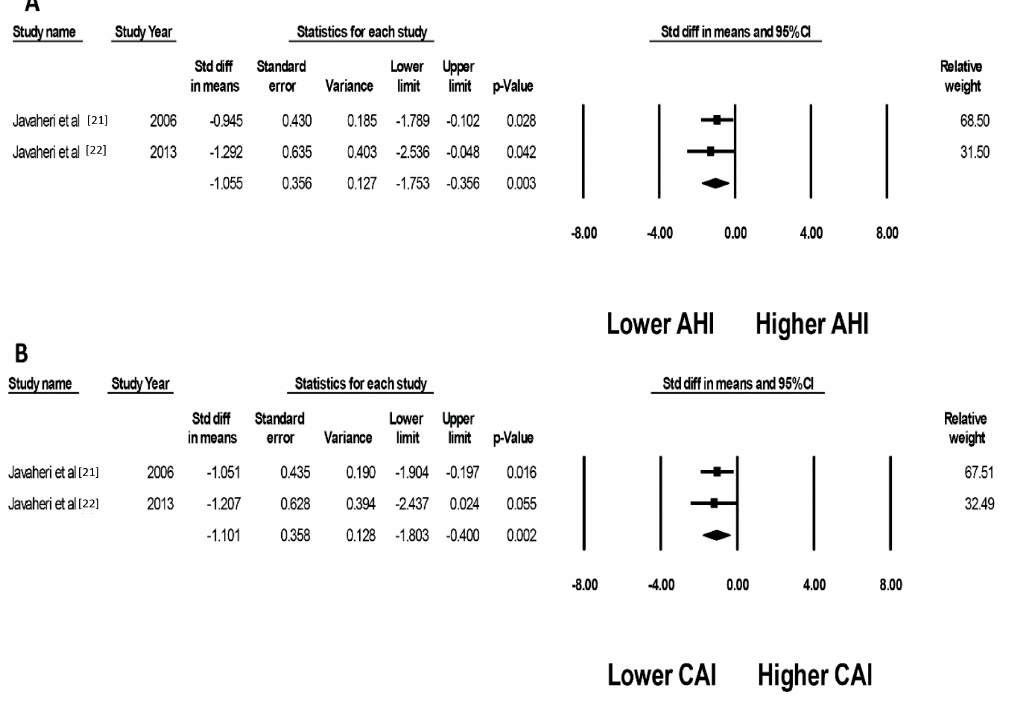
Figure 4. Forest plots of the included studies evaluating effects of acetazolamide on ( A ) apnea-hypopnea index (AHI); and ( B ) central apnea index (CAI). A diamond data marker represents the overall rate from each included study (square data marker) and 95% CI.